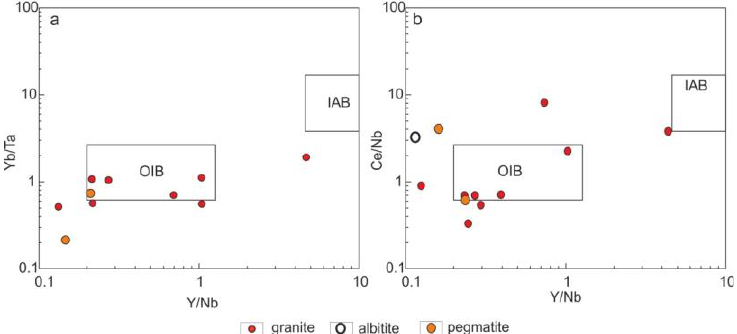
Figure 20. Yb/Ta vs. Y/Nb ( a ) and Ce/Nb vs. Y/Nb ( b ) diagrams for rocks of the Somnitelnyi massif and Tommot deposit . Fields in the diagram [70]: OIB — field of oceanic island basalts; IAB — field of granites formed from basalts of island arcs and continental margins or by partial melting of the crust.